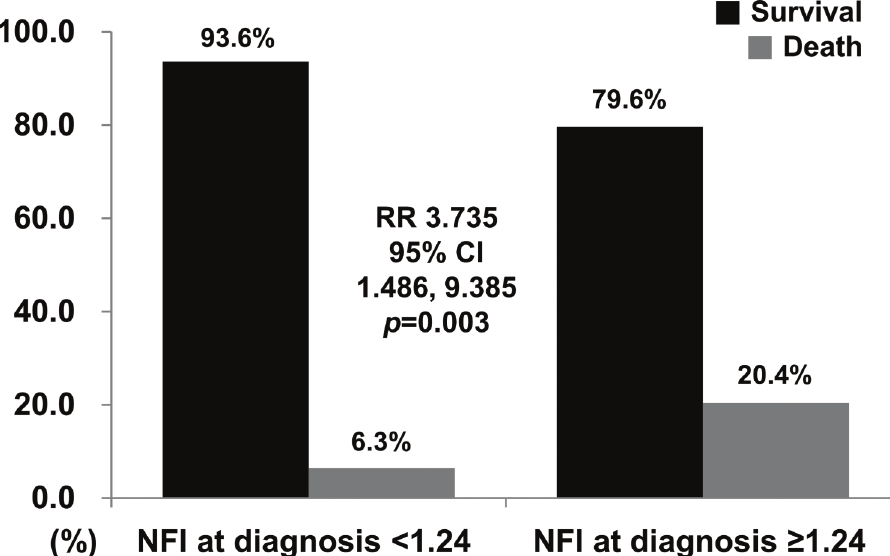
Figure 3 - Relative Risk for all-cause mortality. AAV patients with NFI at diagnosis X 1.24 had a significantly higher risk for all-cause mortality than those with NFI at diagnosis o 1.24 (RR 3.735). NFI: novel fibrosis index; RR: relative risk; CI: confidence